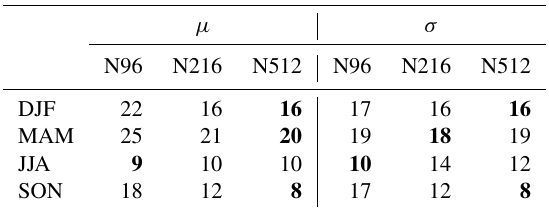
Table 2. Median across all basins of absolute relative bias (%; see Sect. 4.2) in µ and σ . Numbers in bold indicate the resolution with the smallest